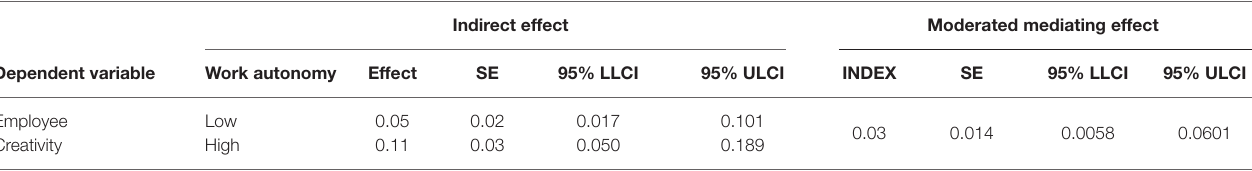
TABLE 4 | Bootstrap test results of moderated mediating